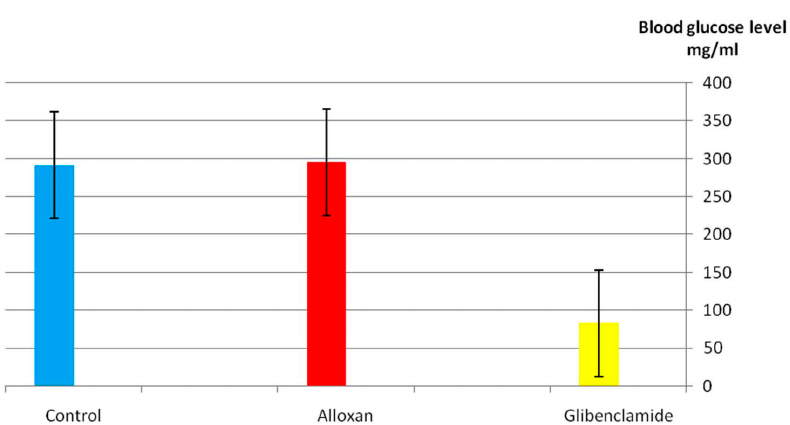
Fig. 5. Effect of the glibenclamide drug in blood glucose level of laboratory rats after 6hrs of treatment